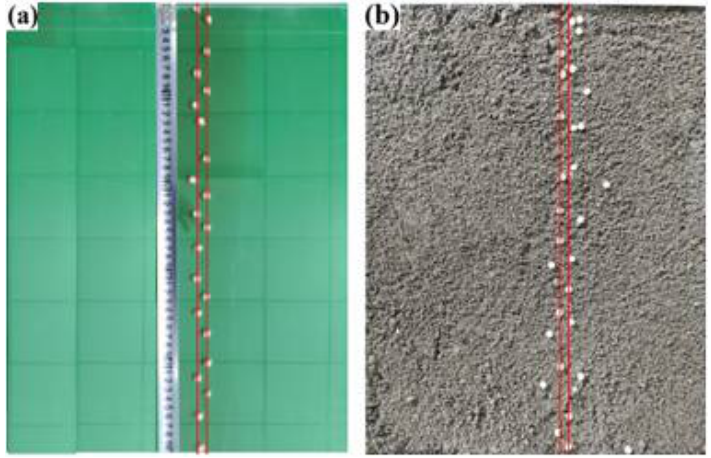
Figure 18. Distribution of soybean seed particles on the ( a ) seedbed belt and ( b ) soil tray.